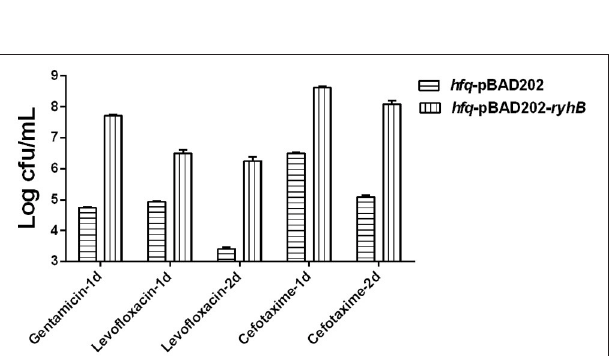
FIGURE 4 | Effect of RyhB overexpression on persister formation in the hfq -knockout mutant. Antibiotics were added to stationary phase bacteria ( ∼ 10 9 CFU/mL) at the appropriate concentrations (gentamicin: 30 µ g/mL; levofloxacin: 5 µ g/mL; cefotaxime: 128 µ g/mL). The number of persisters was counted at the time points indicated in the figure. Error bars show standard variations in CFU between at least three independent experiments. hfq -pBAD202, Hfq-knockout mutant carrying the empty vector pBAD202; hfq -pBAD202- ryhB, Hfq-knockout mutant carrying the ryhB -overexpression vector pBAD202- ryhB